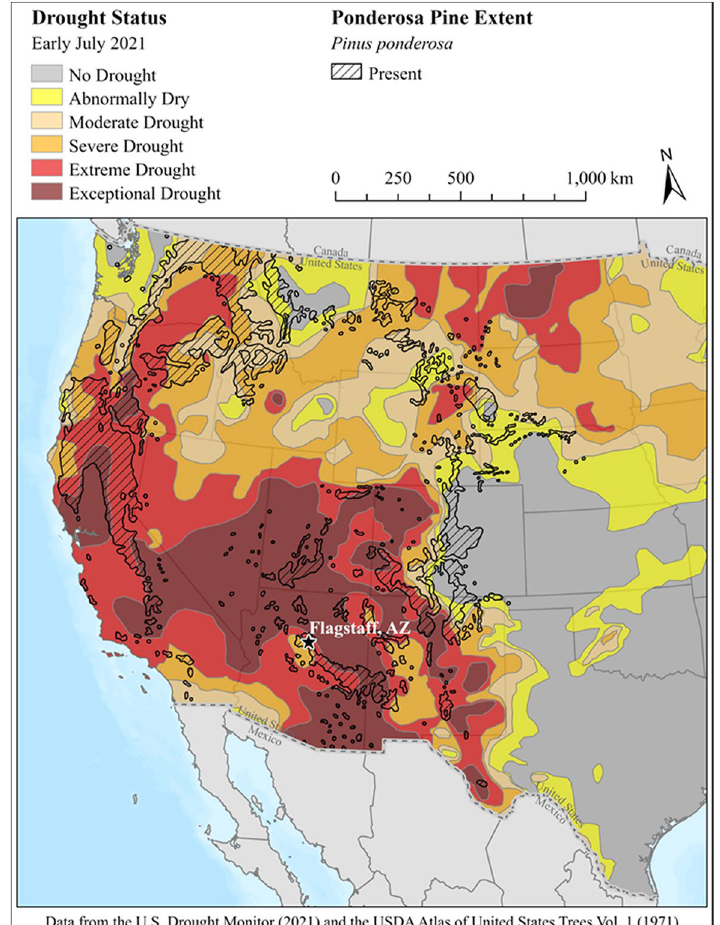
Figure 1. Drought status across the western US in July, 2021 (GIS data from Little, 1971, and US Drought Monitor, 2021).